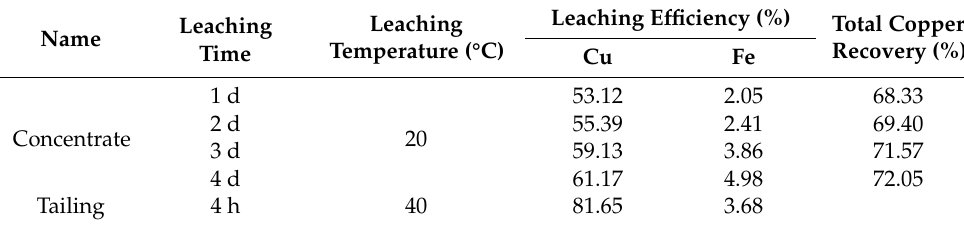
Table 4. Magnetic concentrate and tailing leaching results.